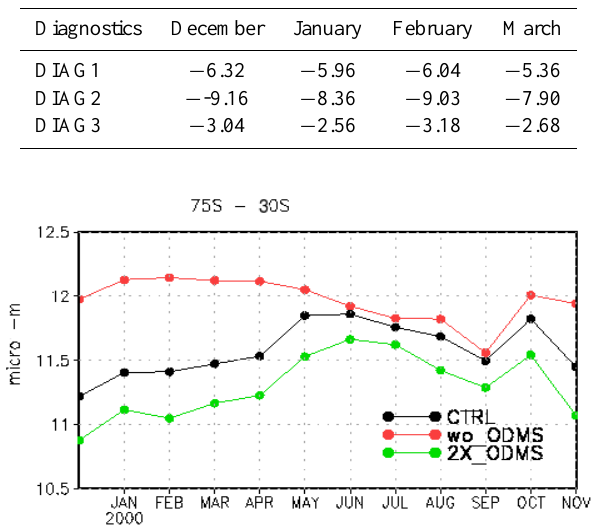
Fig. 3. Same as in Fig. 2, but, for, the cloud droplet effective radii ( µ m).